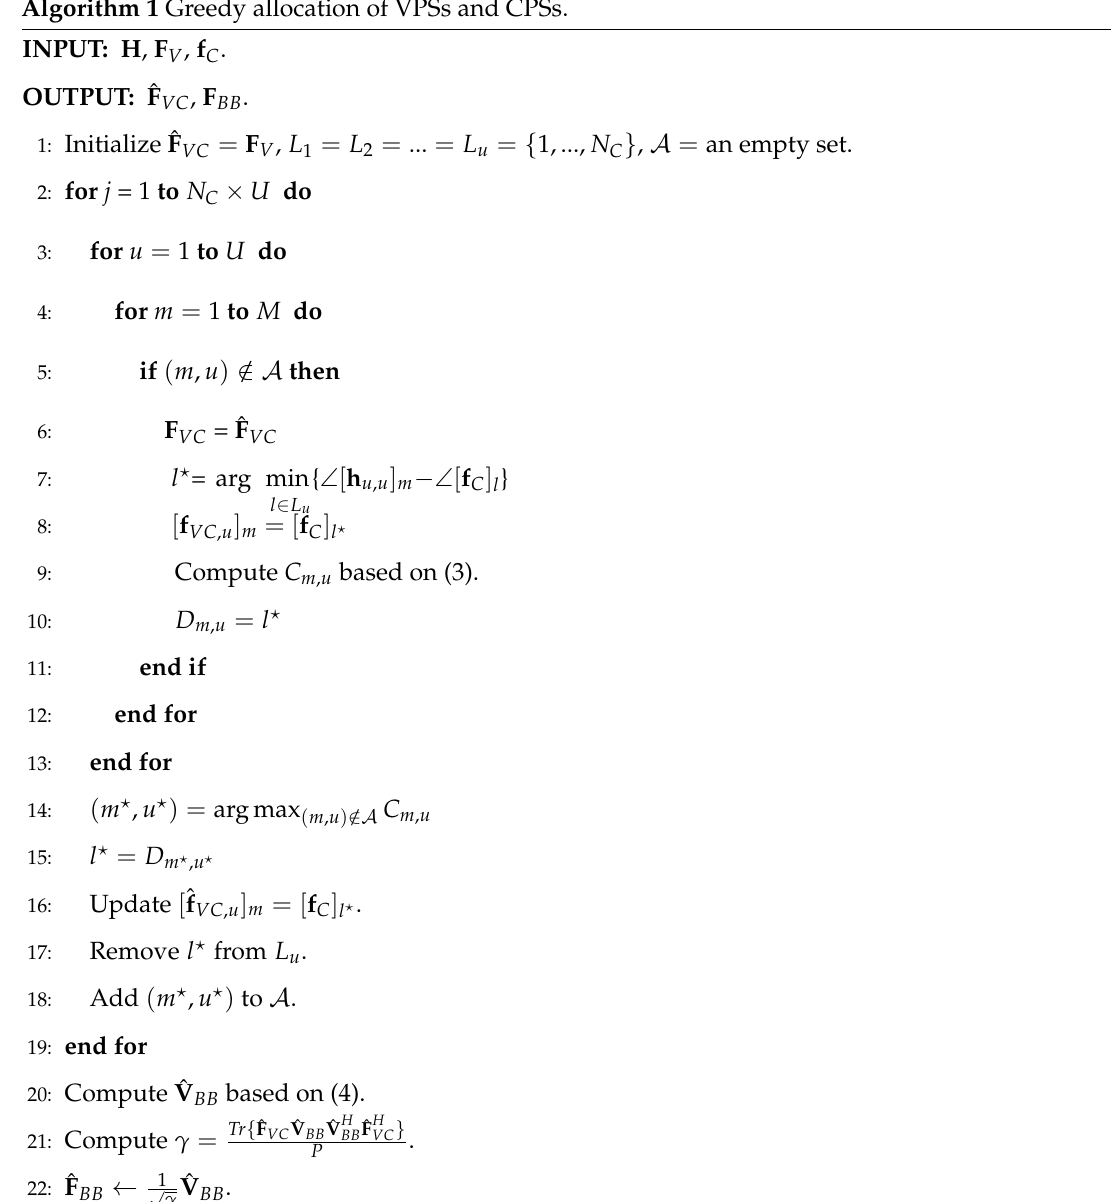
Algorithm 1 Greedy allocation of VPSs and